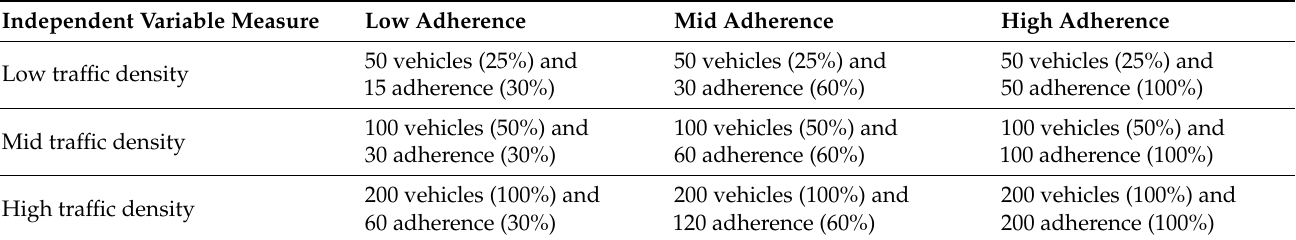
Table 3. Experiment conditions.